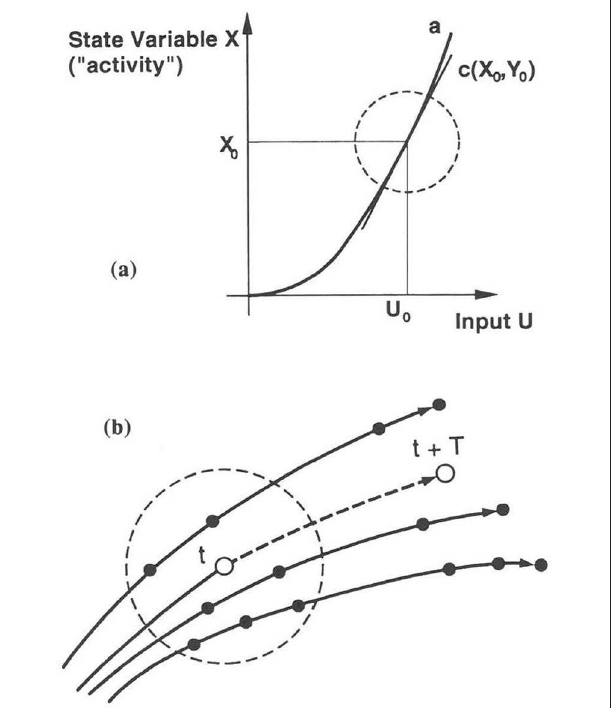
FIGURE 10 | (a) Illustration of a simple nonlinear relationship between the state of the magnetosphere (X) and solar wind input (U); (b) Neighboring trajectories through magnetospheric state